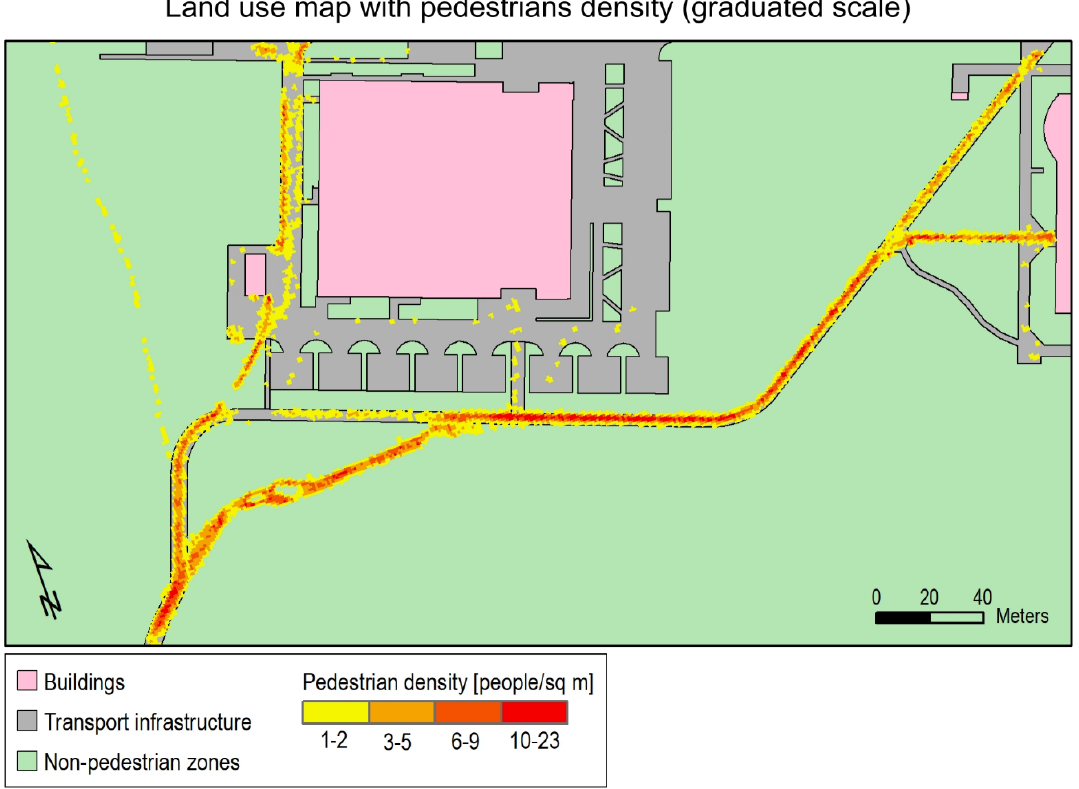
Figure 10. The map of pedestrian density in the research area (graduated scale): the chorochromatic method (qualitative data).